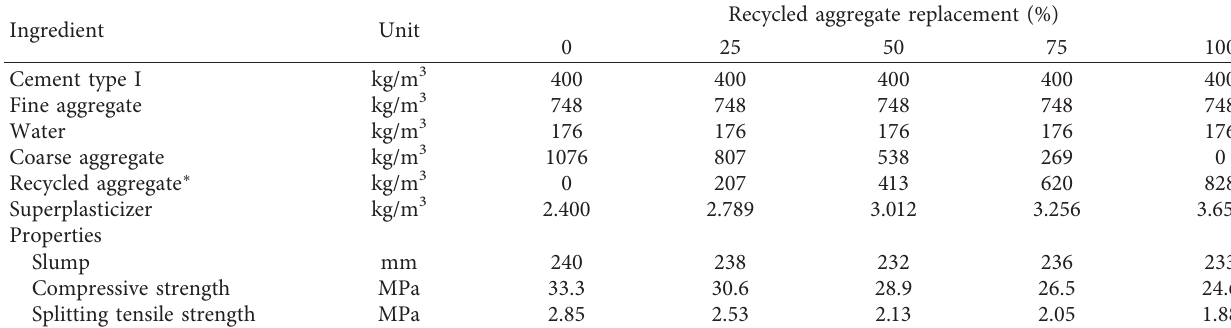
Table 2: Concrete mixture proportions and